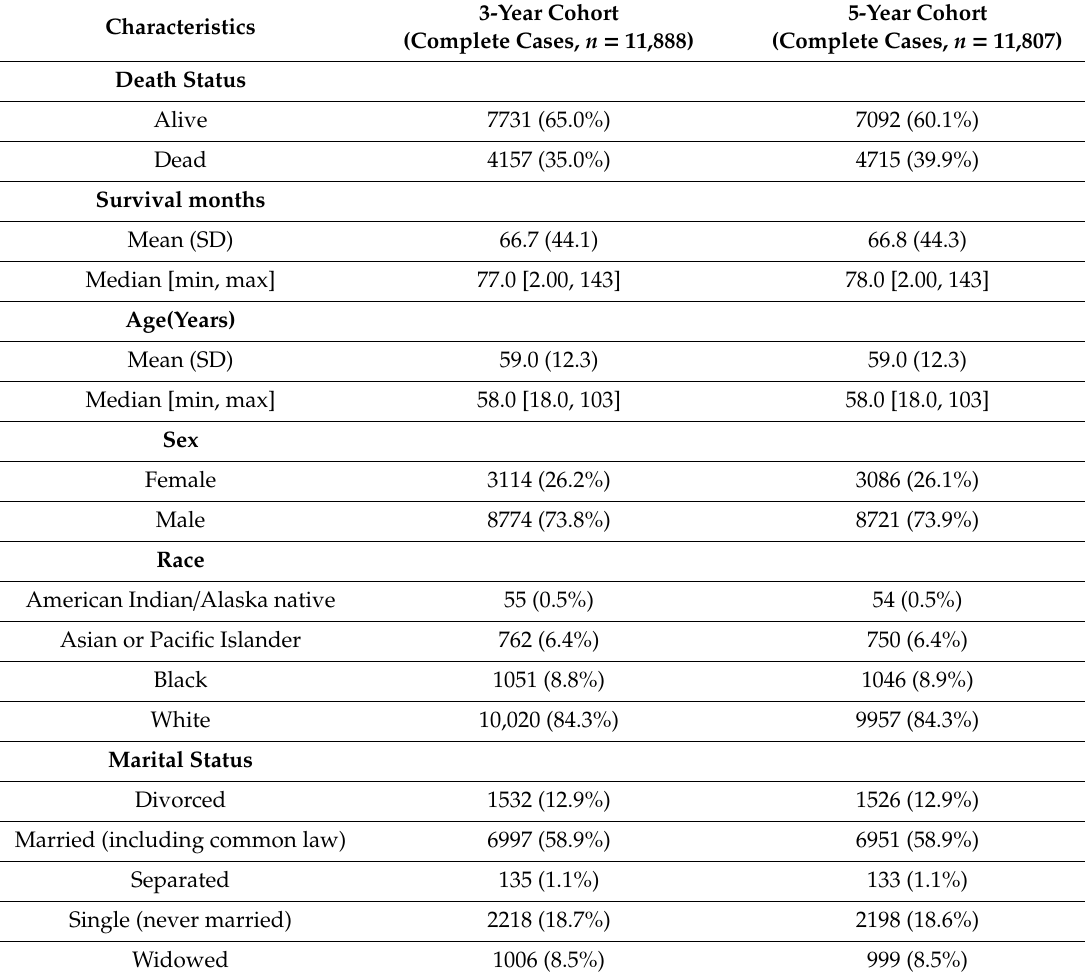
Table 1. Demographic characteristics of patients with oral and pharyngeal cancers in SEER (Surveillance, Epidemiology, and End Results)